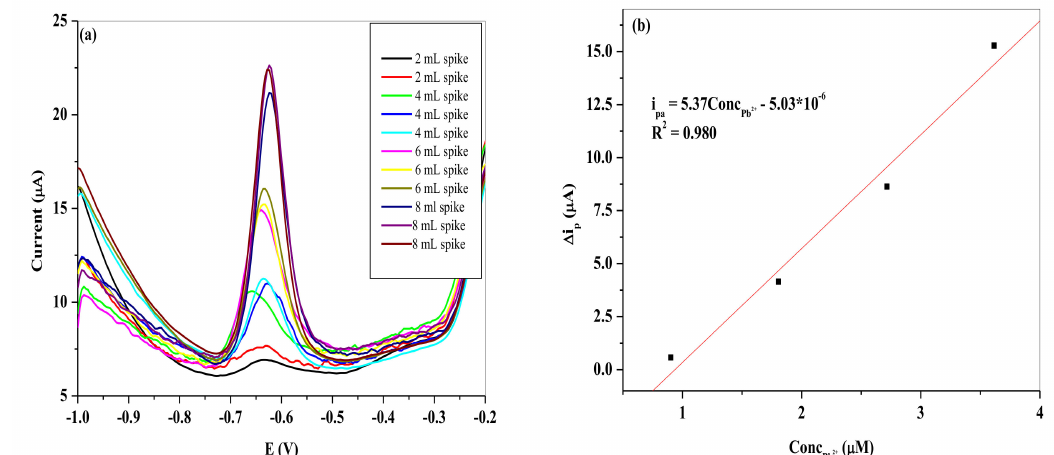
Figure 18. Represent (a) the SWV of the different spikes with Pb 2+ concentration and ( b ) the resultant calibration curve at SPCE/LPE/BiONPs/PANI at optimum conditions. (Potential vs. Ag/AgCl).